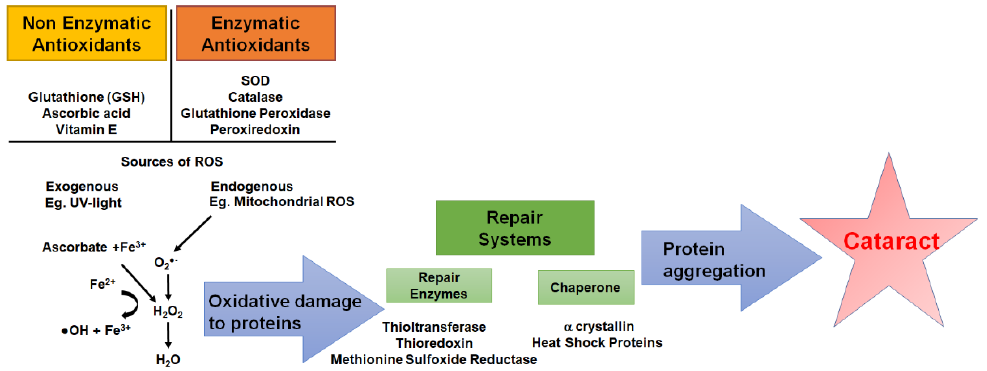
Figure 4. Schematic of the antioxidant defence systems of the lens. To protect against exogenous and endogenous sources of reactive oxygen species (ROS), the lens utilises nonenzymatic antioxi- dants such as glutathione (GSH), ascorbic acid, and vitamin E along with enzymatic antioxidants such as superoxide dismutase (SOD), which neutralises the superoxide radical (O 2 - • ) and catalase, glutathione peroxidase (GPx) and peroxiredoxins, which neutralises H 2 O 2 into H 2 O and molecular oxygen (O 2 ). Repair systems such as the repair enzymes thioltransferase, thioredoxin, methionine sulfoxide reductase, and chaperone proteins work to repair oxidised proteins. However, depletion of antioxidant capacity coupled with a failure to repair damaged proteins results in protein aggregation, increased light scattering, and ultimately cataract formation.